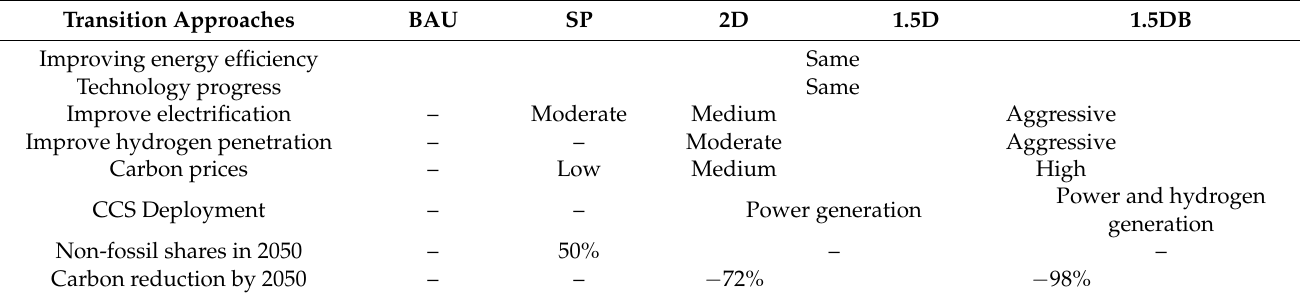
Table 1. Scenarios